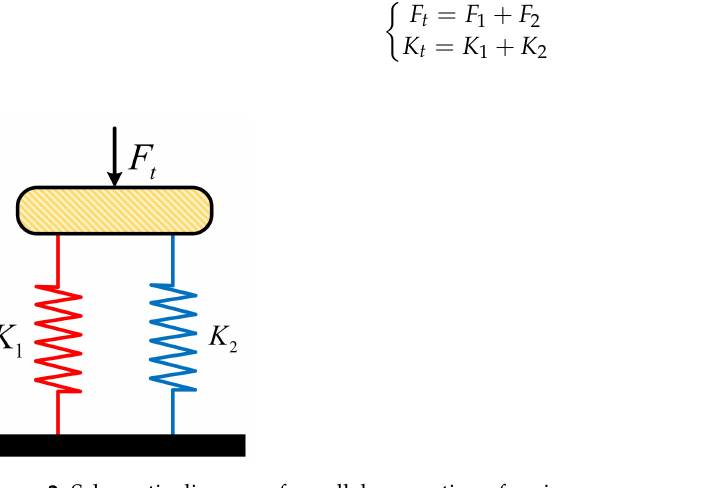
Figure 2. Schematic diagram of parallel connection of